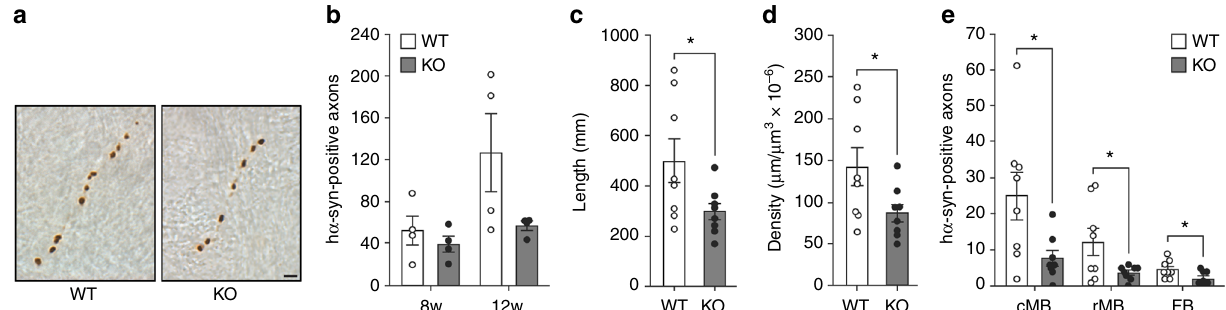
Fig. 2 Effects of Lrrk2 ablation in α -synuclein spreading in rats. Spreading of α -synuclein is decreased in LRRK2-de fi cient rats. Wild-type (WT) and LRRK2- de fi cient (KO) rats received a single injection of AAVs encoding human α -synuclein (h α -syn) into the left vagus nerve. Spreading of α -synuclein was analyzed 8 and 12 weeks later. a Representative images of axons stained with an antibody against human α -synuclein in the left (AAV-injected side) pons of a WT and a KO rat killed at 12 weeks post-AAV injection. Scale bar: 5 μ m. b The number of axons immunoreactive for human α -synuclein was quanti fi ed in the left pons (Bregma: − 9.48 mm) of WT ( N = 4/time point) and KO ( N = 4/time point) rats. Error bars represent SEM. c, d Length ( c ) and density ( d ) of axons immunoreactive for human α -synuclein were estimated in the left pons in an area encompassing the coeruleus/subcoeruleus complex and the parabrachial nucleus. Samples were obtained from rats killed at 8 ( N = 4 WT and N = 4 KO) and 12 ( N = 4 WT and N = 4 KO) weeks post-AAV injection and, for each animal, measurements were carried out on three separate pontine sections. Data at the two time points were pooled and analyzed together. Error bars represent SEM, * p < 0.05 by unpaired, two-tailed Student ’ s t test. e The number of axons positive for human α -synuclein was quanti fi ed in the left caudal midbrain (cMB; Bregma: − 7.8 mm), rostral midbrain (rMB; Bregma: − 6.0 mm) and forebrain (FB; Bregma: − 2.4 mm) of WT ( N = 4 at 8 weeks and N = 4 at 12 weeks) and KO ( N = 4 at 8 weeks and N = 4 at 12 weeks) rats. Error bars represent SEM, * p < 0.05 by unpaired, two-tailed Student ’ s t